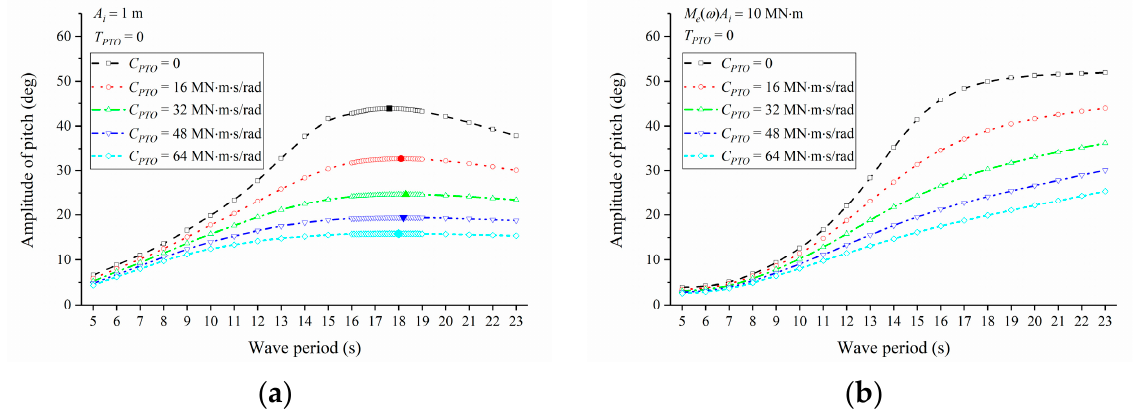
Figure 19. The pitch amplitude results of a no-friction flap ( T PTO = 0) for various values of PTO damping C PTO under regular waves of: ( a ) uniform wave amplitude; ( b ) uniform wave exciting moment amplitude.